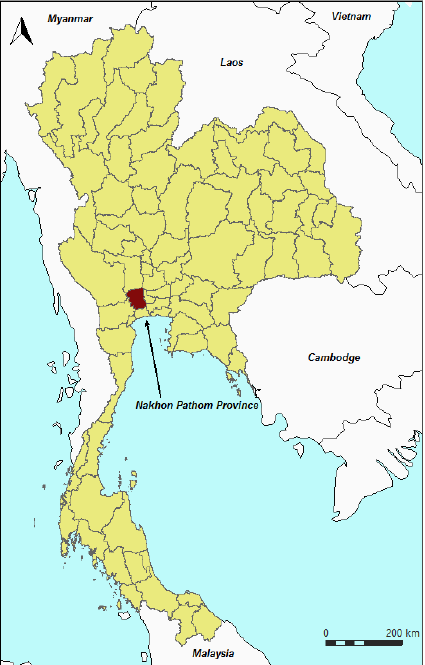
Figure 1. Nakhon Pathom province in Thailand.